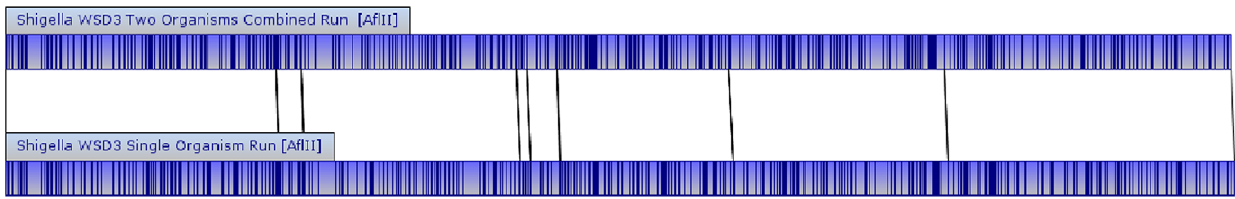
Figure 3. Shigella Genomes. Complete circularized S. dysenteriae genomes from mixed DNA mapcard run aligned to genome from individual run.